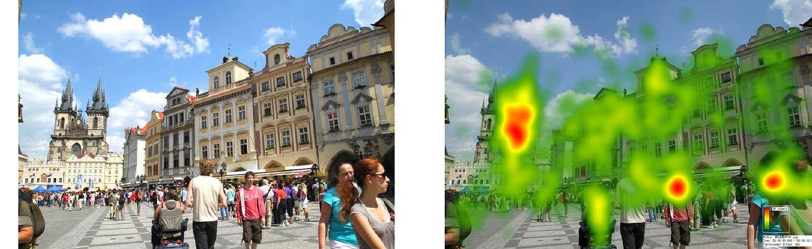
Fig. 10 The comparison of eye motion and heatmap for Old Town Square.